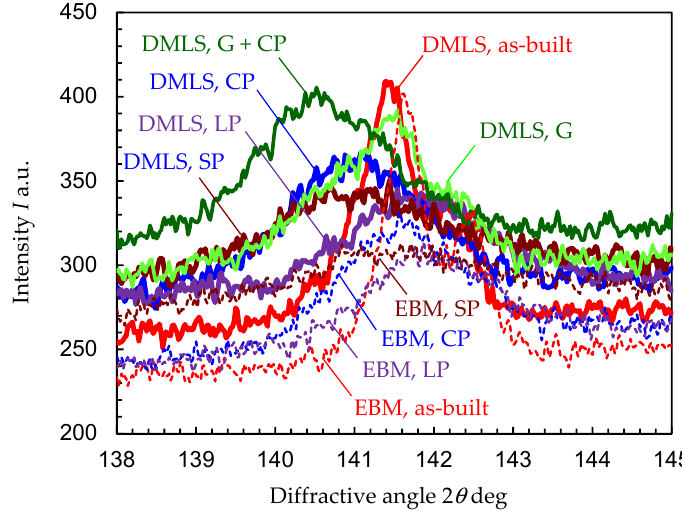
Figure A1. X-ray diffraction pattern for the Ti6Al4V manufactured by DMLS and EBM through cavitation peening (CP), laser peening (LP), shot peening (SP) grinding (G), and cavitation peening after grinding (G + CP), compared with the as-built specimen.